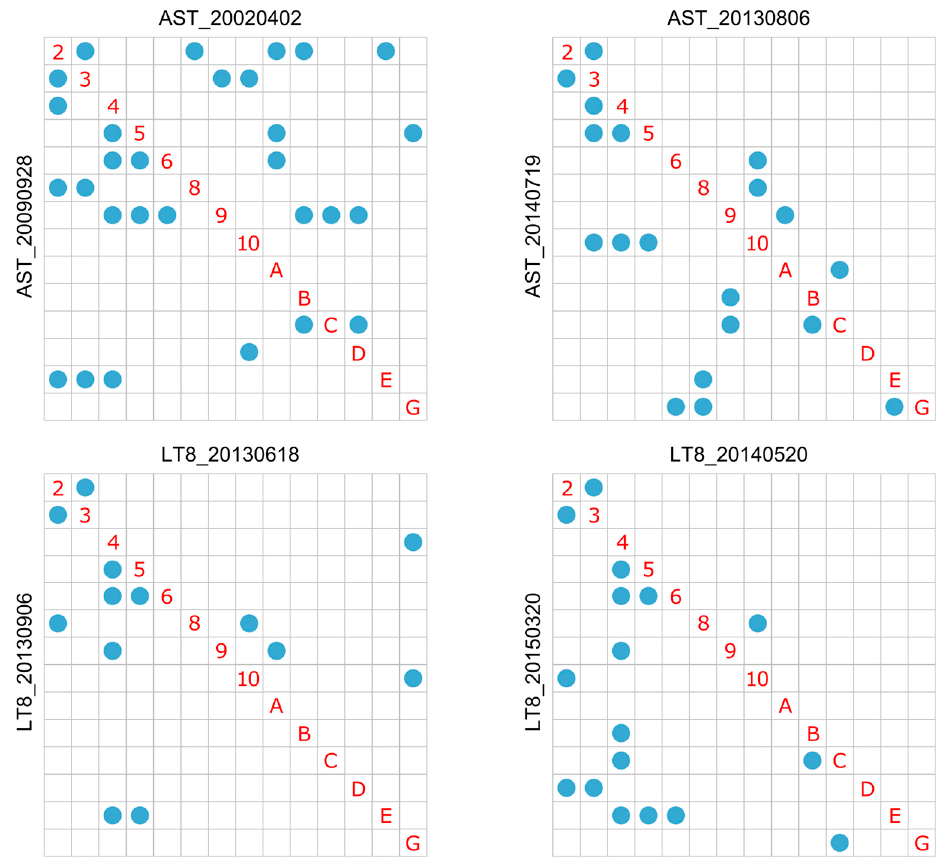
Figure 9. Results of the Tukey-HSD test for all combinations of LCZ classes (red numbers and letters) and for all analyzed scenes in Brno; see Table 3 for the scene ID; blue points indicate pairs of LCZs for which LSTs are not significantly different ( p > 0.05), while empty cells denote LCZs pairs for which average LSTs are significantly different.